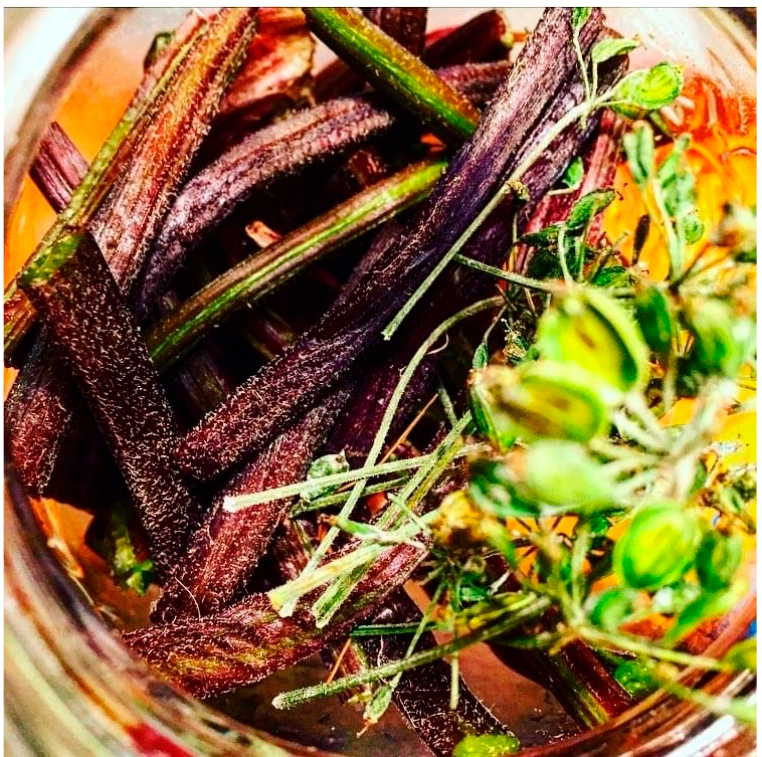
Figure 6. Hogweed and burdock ‘fake artichokes’. Picture and recipe by Eleonora Matarrese. The full recipe is available in the Supplementary Materials.